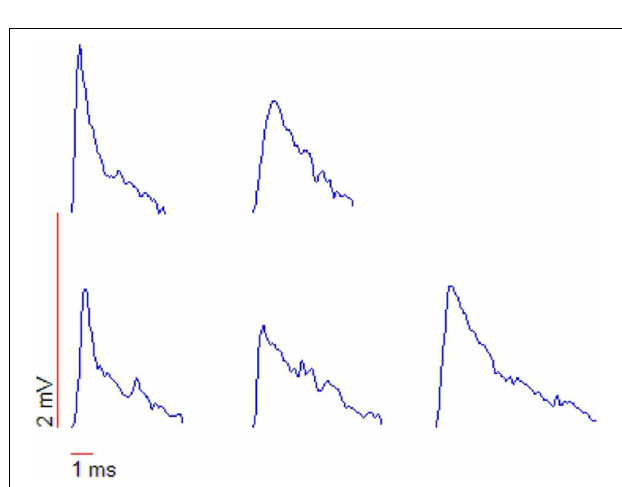
FIGURE 8 | Shapes of action potentials recorded with whole-cell patch measurements. Note the “peculiar” triangular form, typical of the leading edge of a spiral waveform. From Huang (2009), copyright The Author.